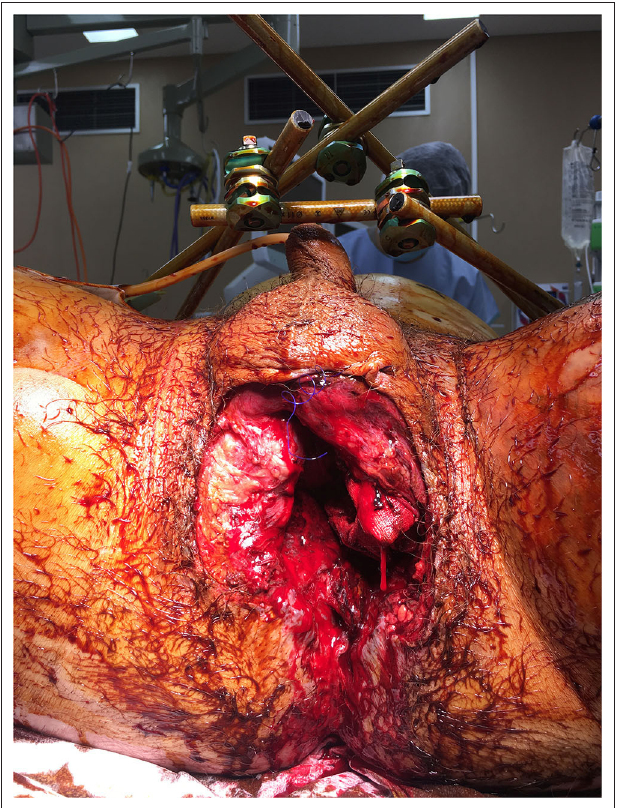
FIGURE 2 | Intraoperative photo showing massive pelvic floor and perianal disruption from open pelvic fractures.